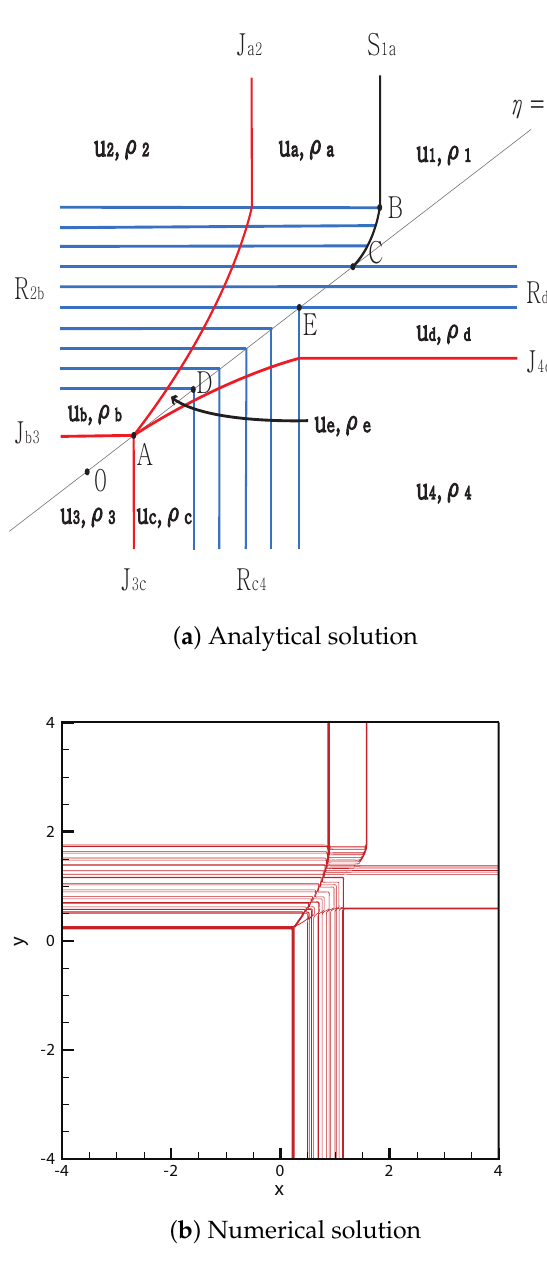
Figure 7. Case 5. SJ + RJ + JR +